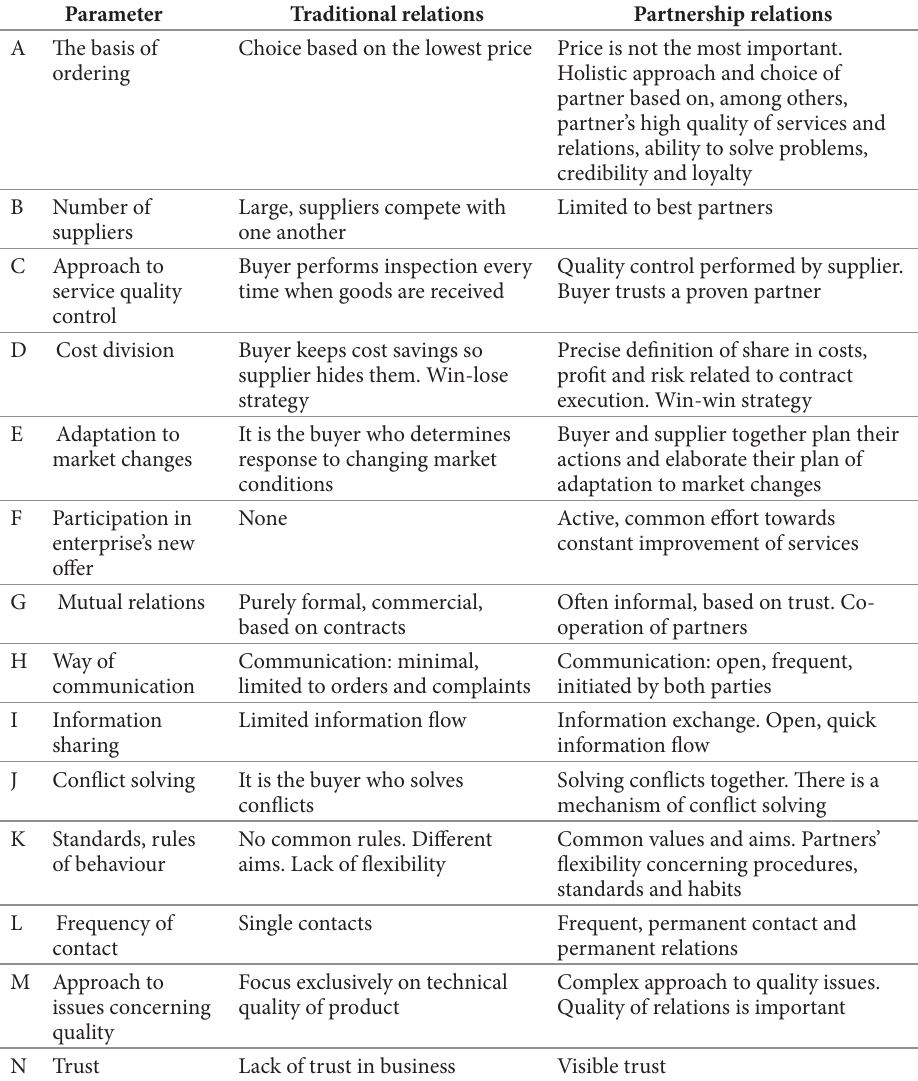
Table 1. The adopted symbol and name of a relation parameter and its characteristics in the traditional and the partnering approach Parameter Traditional relations Partnership